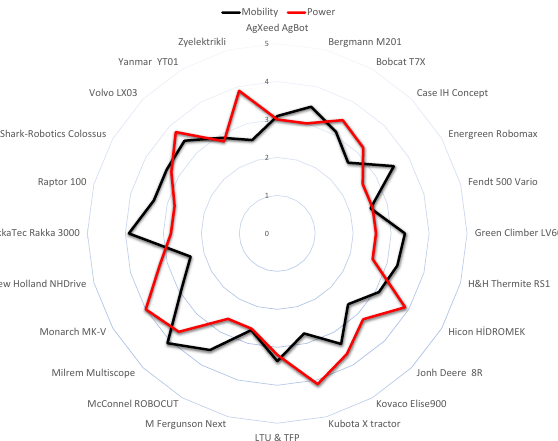
Figure 9. MIM overall evaluation: mobility and power Key Performance Indicator